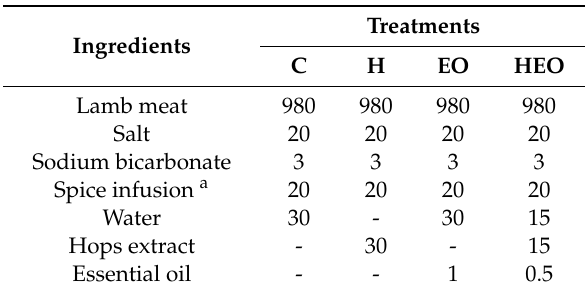
Table 3. Ingredients and amounts (expressed in g or mL, solid or liquids, respectively) used in the sausage preparation for the experimental treatments. Ingredients